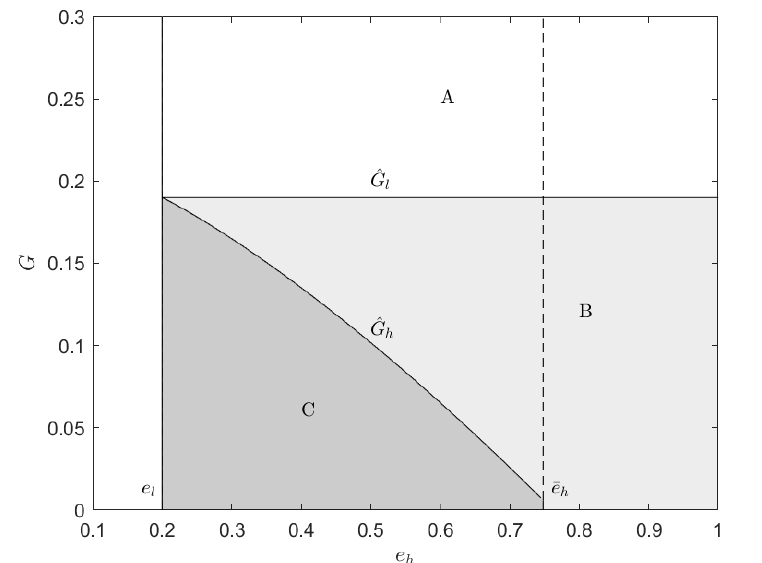
Figure 3. Illustration of Different Impacts of the cap-and-trade Mechanism. The parameters are t = 1, p c = 0.3, µ = 0.5, G = 0, a = 1, b = 0.2, and e l =